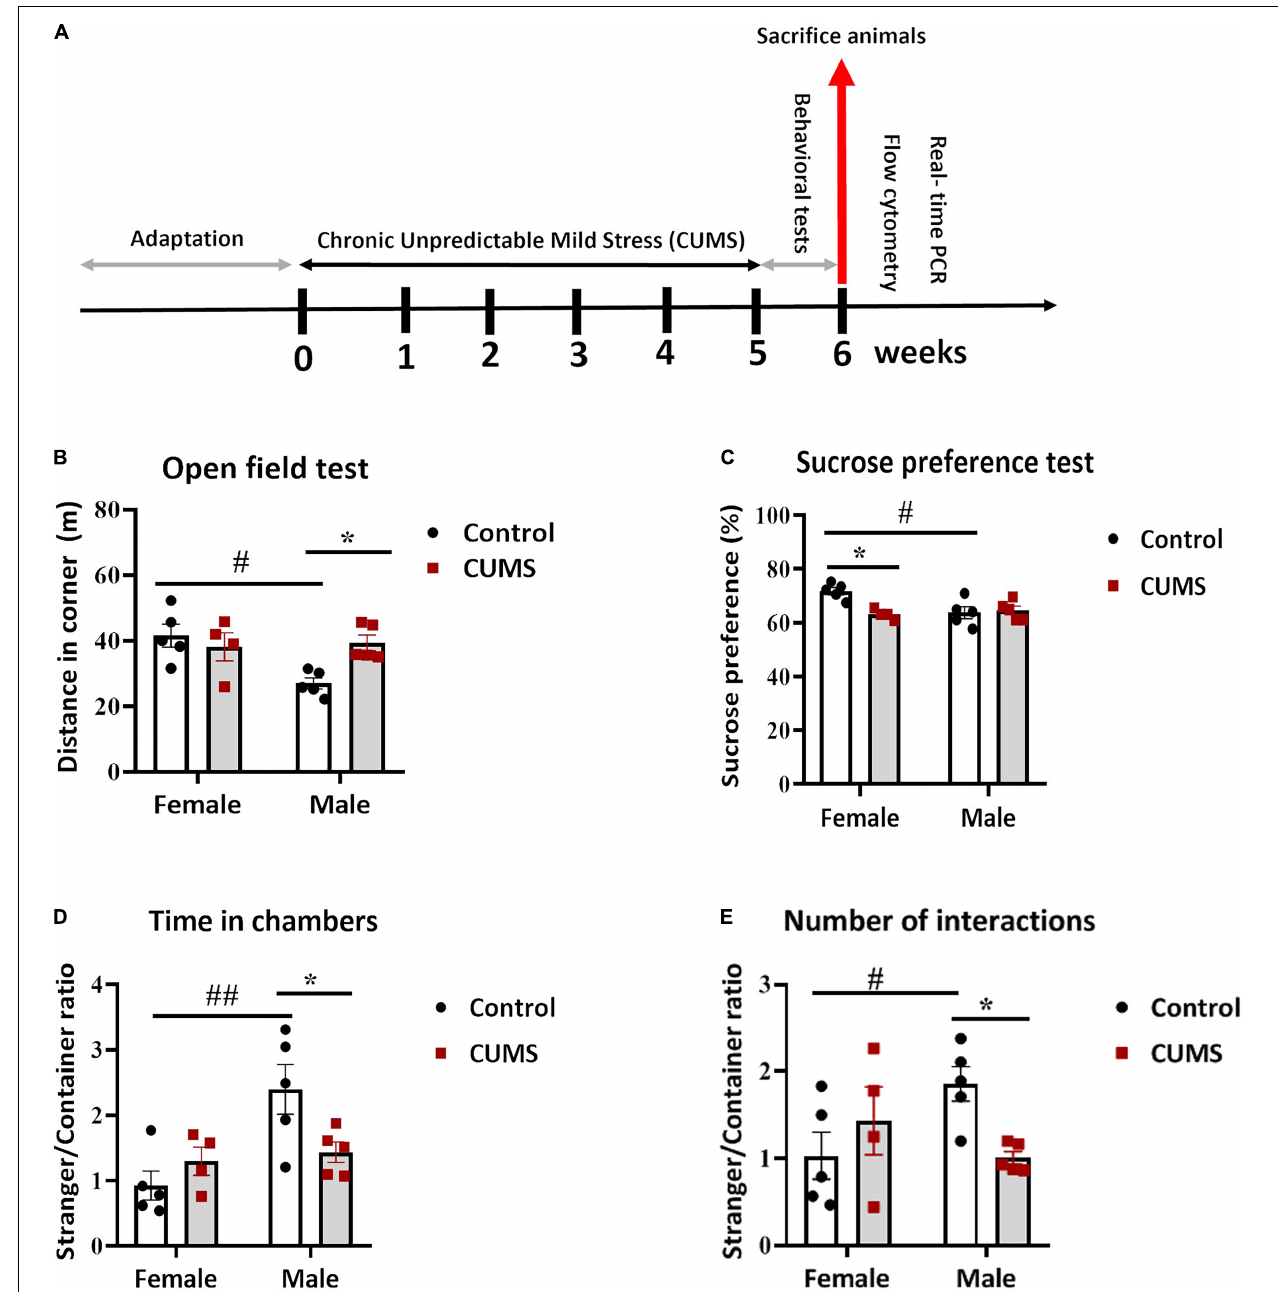
FIGURE 1 | Chronic unpredictable mild stress (CUMS) induced depressive-like behavior in female mice and anxious and social withdrawal in male mice. (A) A schema representing experimental design. (B) In the open field test, control male mice traveled less in the corners than control female mice, whereas CUMS males traveled more than control male mice. (C) Control female mice consumed more sucrose than control male mice, whereas CUMS female mice consumed less than control female mice. (D,E) . In the three chamber sociability test, control male mice were more social than control female mice, in terms of ratios of the time spent in a chamber with a stranger mouse vs. that with an empty container (D) and the number of interactions with the stranger mouse vs. the empty container (E) , respectively, whereas CUMS male mice showed less sociability than control male mice. The symbols * and # represent CUMS and sex differences, respectively (two-way ANOVA). * p < 0.05, ** p < 0.01, and # p <